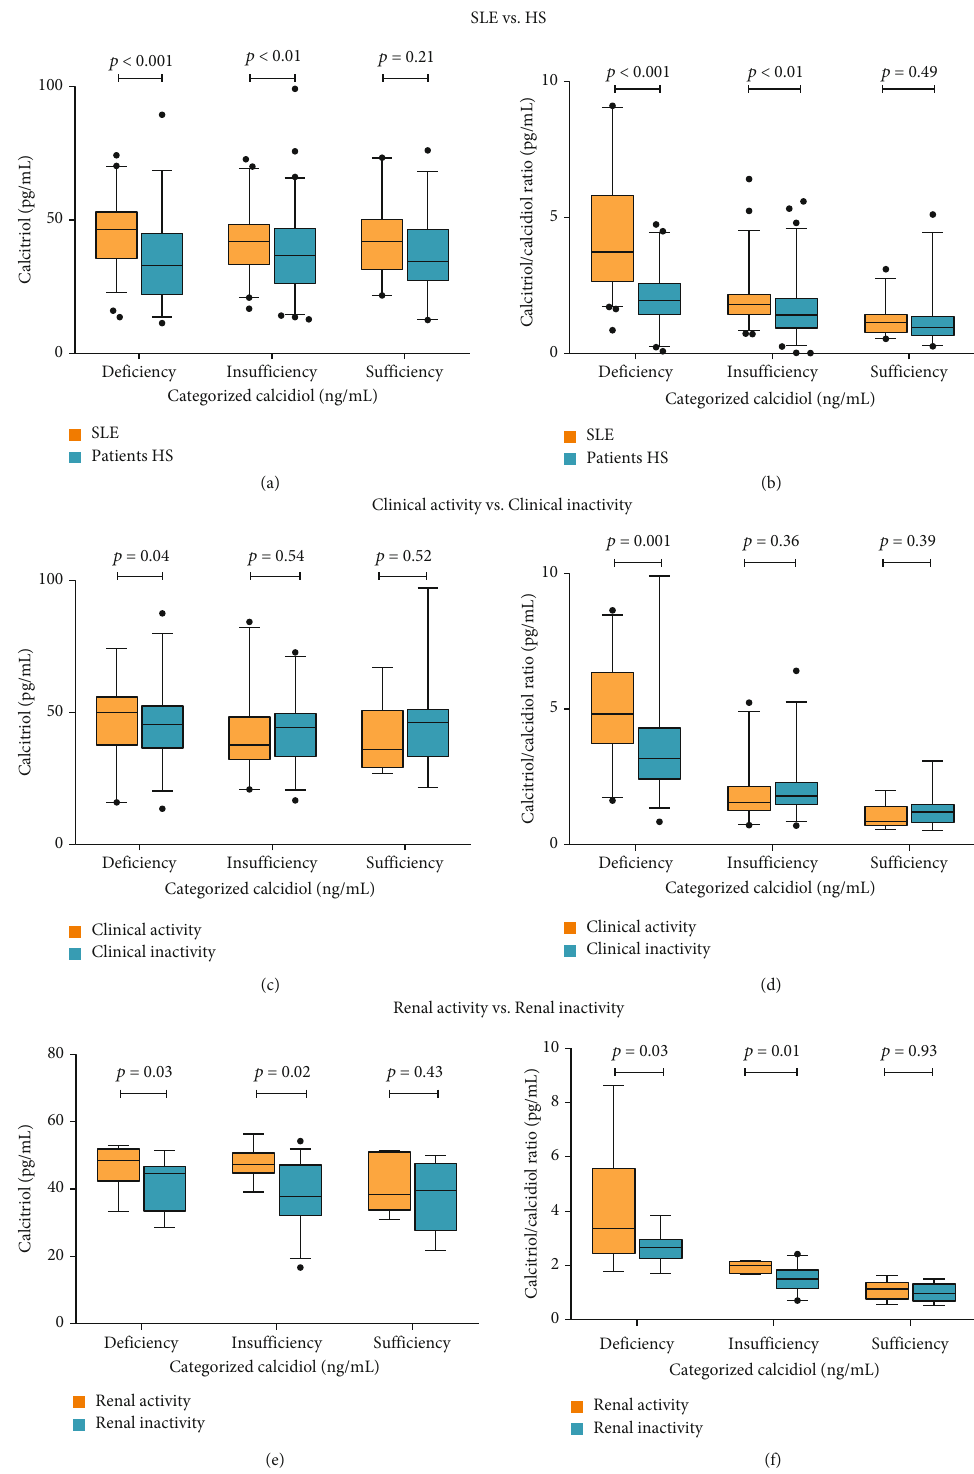
Figure 3: Calcitriol serum levels and vitamin D hydroxylation e ffi ciency ratio strati fi ed by the calcidiol reference values. (a) Calcitriol serum levels (pg/mL) from SLE patients vs. HS, (b) E ffi ciency of vitamin D hydroxylation (pg/ng) from SLE patients vs. HS; (c) calcitriol serum levels (pg/mL) from SLE patients with clinical activity vs. SLE patients with clinical inactivity; (d) e ffi ciency of vitamin D hydroxylation (pg/ng) from SLE patients with clinical activity vs. SLE patients with clinical inactivity; (e) calcitriol serum levels (pg/mL) from SLE patients with renal activity vs. SLE patients with no renal activity, (f) e ffi ciency of vitamin D hydroxylation (pg/ng) from SLE patients with renal activity vs. SLE patients with no renal activity. Data provided in median, Mann – Whitney test. Calcidiol reference values: de fi ciency ( < 20ng/mL), insu ffi ciency ( ≥ 20 to < 30 ng/mL), and su ffi ciency ( ≥